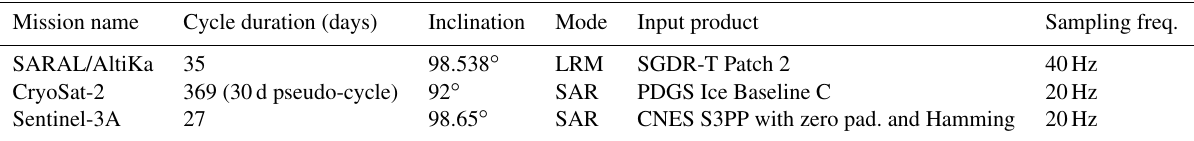
Table 1. Some characteristics of altimeters used.